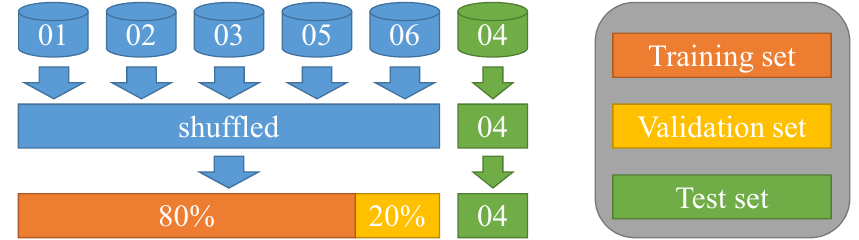
Figure 4. The method of dividing the experimental dataset for